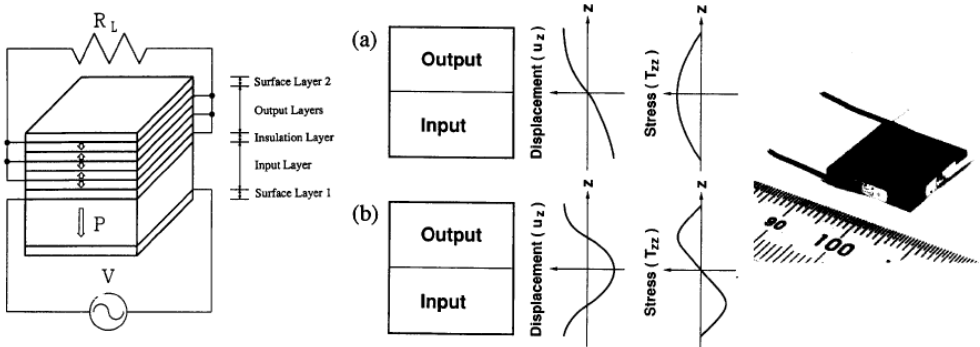
Figure 13. Thickness mode piezoelectric transformer by NEC, 1992 [61,62].